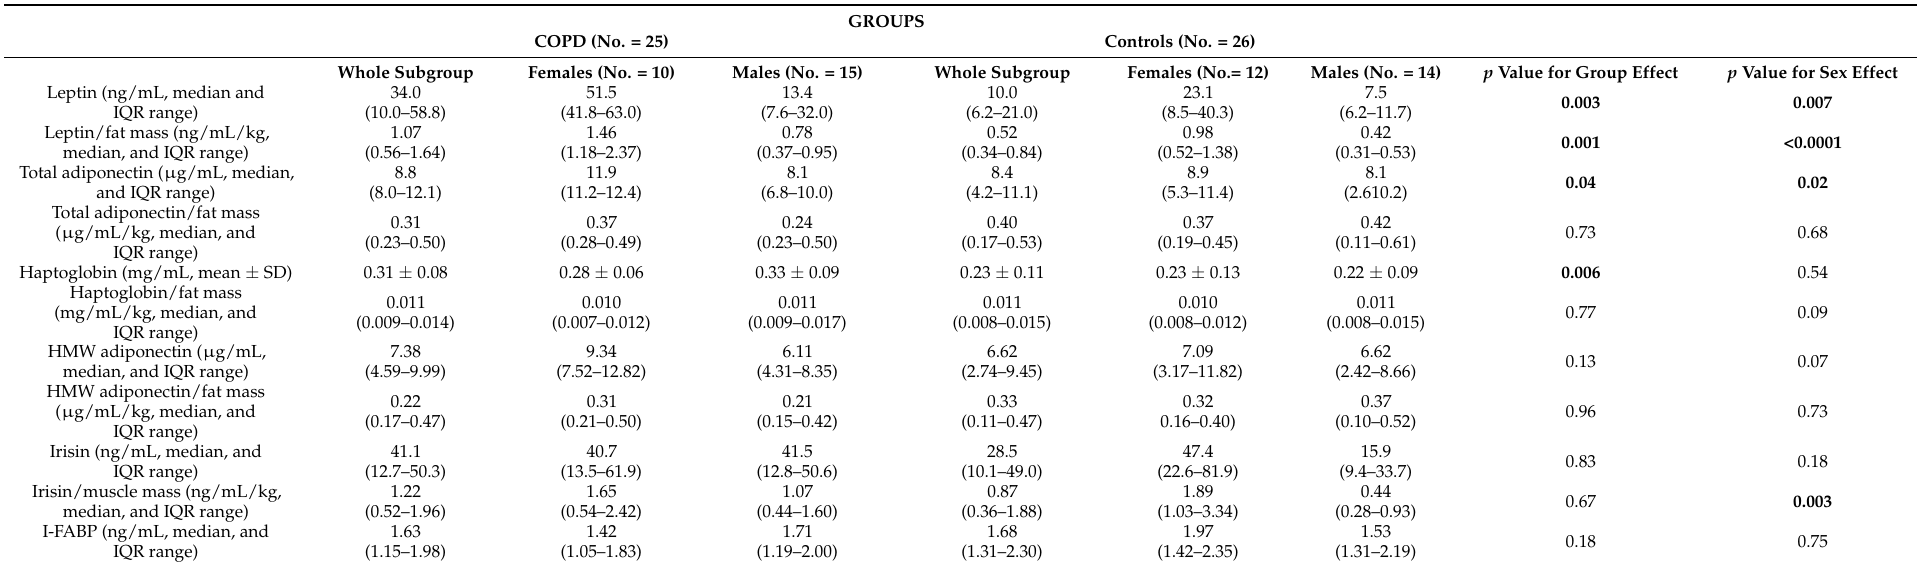
Table 2. Adipocytokines, irisin, and I-FABP circulating levels. Two-way analysis of variance for the effects of group and